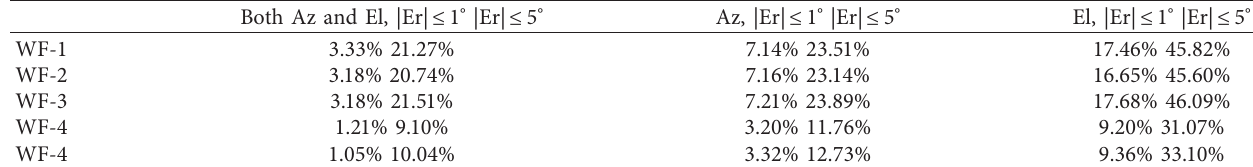
Table 9: Array-3 probability of AoA estimation using 1025 snapshots ( − 20dB ≤ SNR ≤ − 10dB and last line using 513 snapshots).